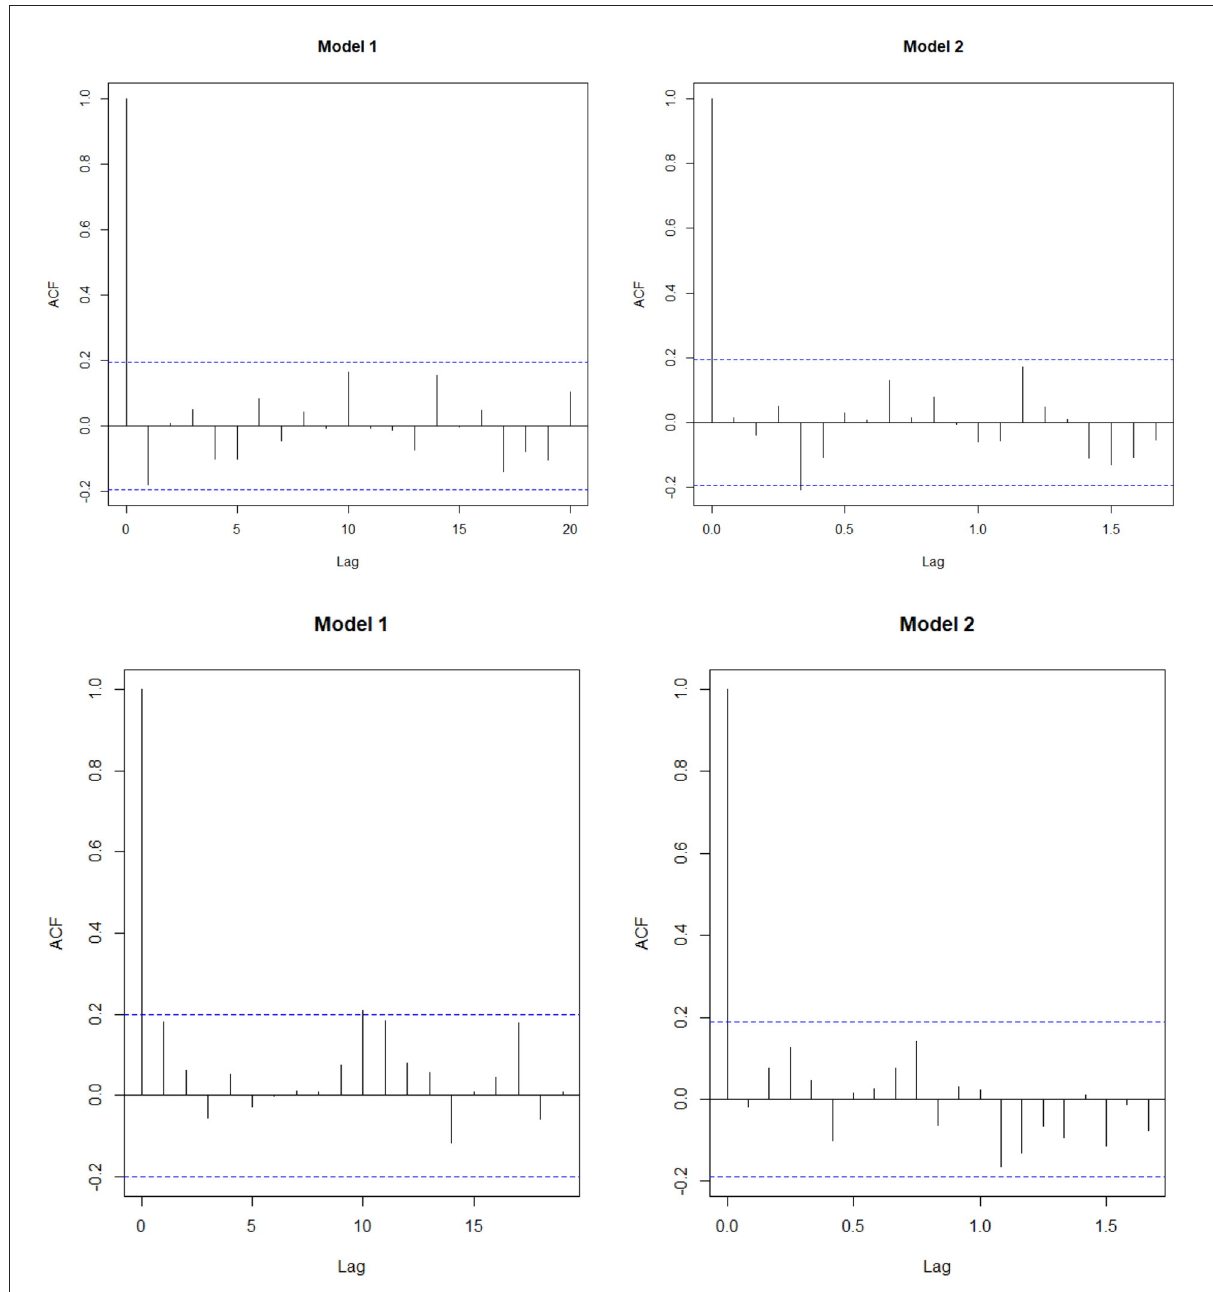
FIGURE3 Sample ACF of the residuals obtained from the fitted models for AMC and CSL.